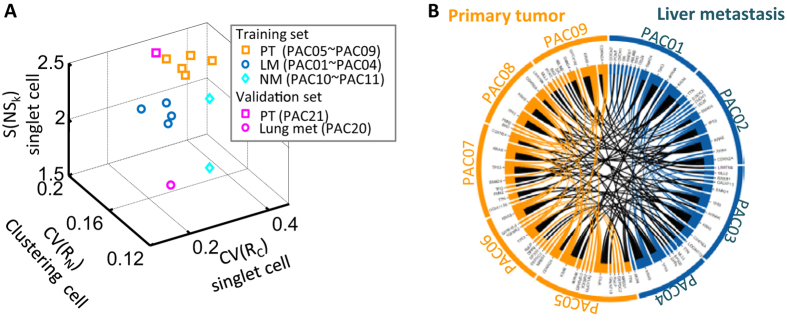
Predictive signature for metastatic pancreatic cancer cells.(A) A 3-D scatter plot shows delineation between different types of samples using CV of nuclear size distribution among cell clusters, CV of cell size distribution among singlet cells and entropy of nucleus shape among single cells for each sample. Three distinct subgroups, respectively composed of PT, LM and NM samples, are readily observed. Two additional patient-derived pancreatic cancer cell lines, a primary tumor cell line (PAC21) and a lung metastases cell line (PAC20), were introduced as validation samples and these two parameters were measured. The location of these two parameters from the new primary tumor derived cell line overlayed well with the PT cluster previously obtained with the training set. The cell line derived from lung metastatic region co-clusters with LM cluster previously obtained with the training set. (B) Relationship of repeating somatic mutations between PT and LM is represented using a Circos plot that is generated using custom software in R. No distinct somatic mutation signature is identified for cells derived from the metastatic site (Interactive Circos plot can be viewed in supplementary materials).